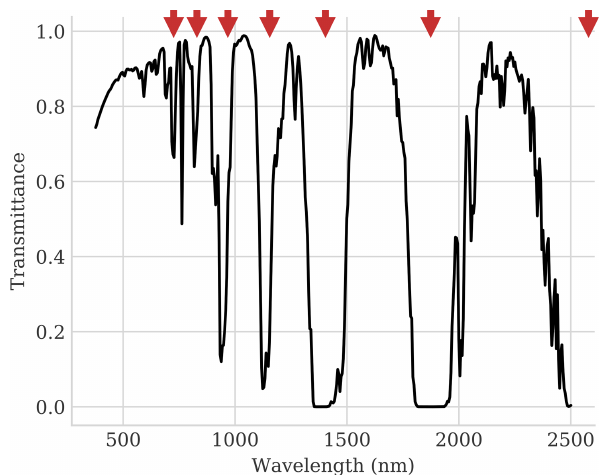
Figure 1. Atmospheric transmissivity from 380–2500nm reveals multiple H 2 O absorption features, indicated with red arrows.